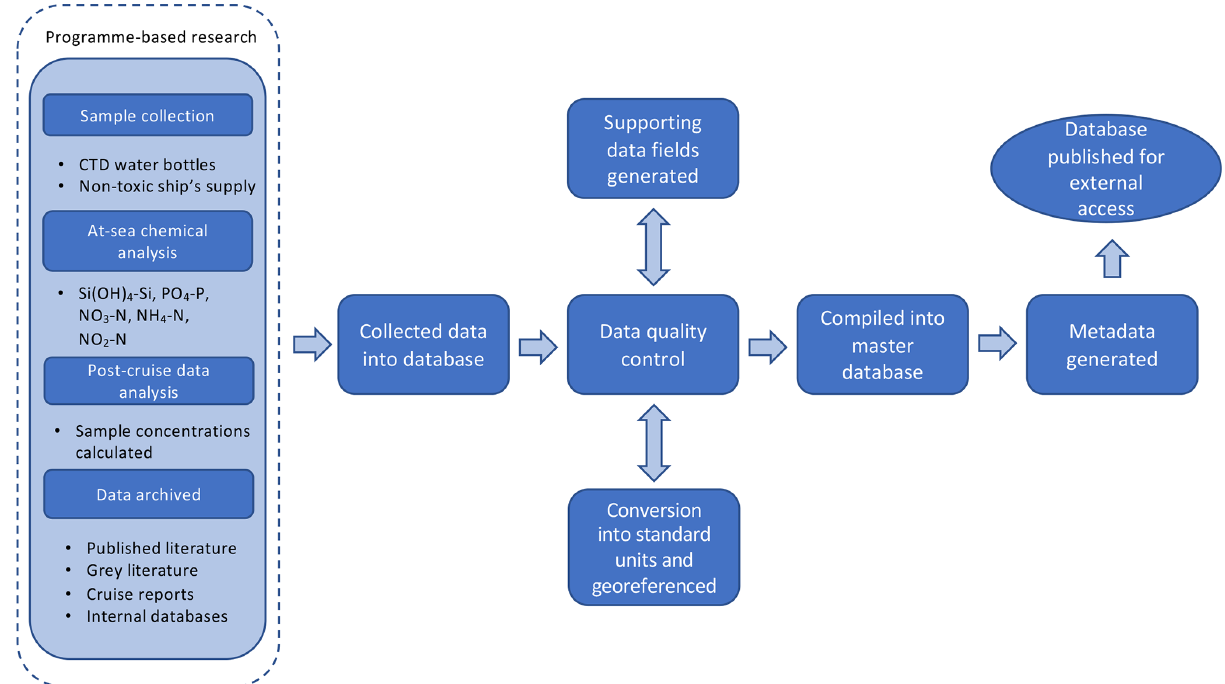
Figure 4. Flowchart of dataset compilation, including sample collection, data processing and